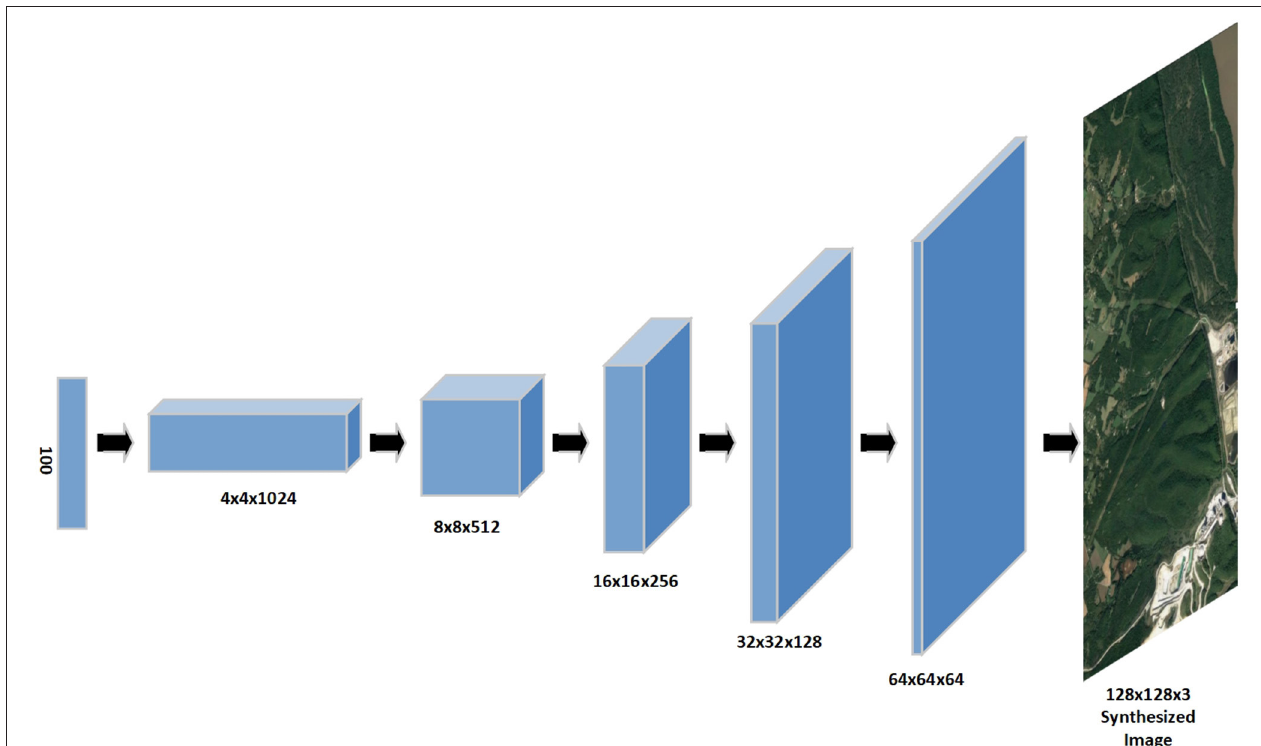
FIGURE 1 | Structure of generator network for 128 × 128